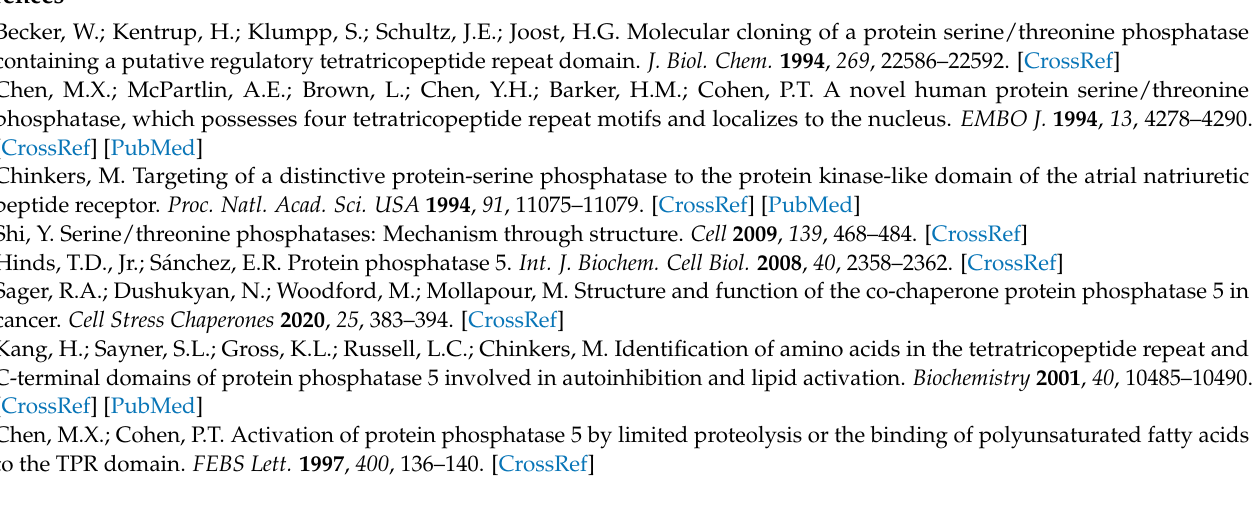
binding assay; Figure S3. In vivo dephosphorylation of Plk4 in D.Mel-2 cells was tested by gel-shift assay; Figure S4. The phospho-status of Plk4 affects its binding to centrosomal proteins, in vitro; Figure S5. Validation of the anti-PP5 antibody and the efficiency of the RNAi; Figure S6. Protein levels of PP5 and Plk4 in Drosophila ontogenetic stages and dissected tissues; Figure S7. Negative controls corresponding to microscopic images shown in Figure 7; Figure S8. Basal body formation and testes morphology are normal in pp5 ∆ mutant flies; Figure S9. Sequences and maps of pMT(Hygro)-NYFP- Myc-GW, pMT(Hygro)-CYFP-HA-GW and pMT(Hygro)-mCherry-GW plasmids; Table S1: List of oligonucleotide